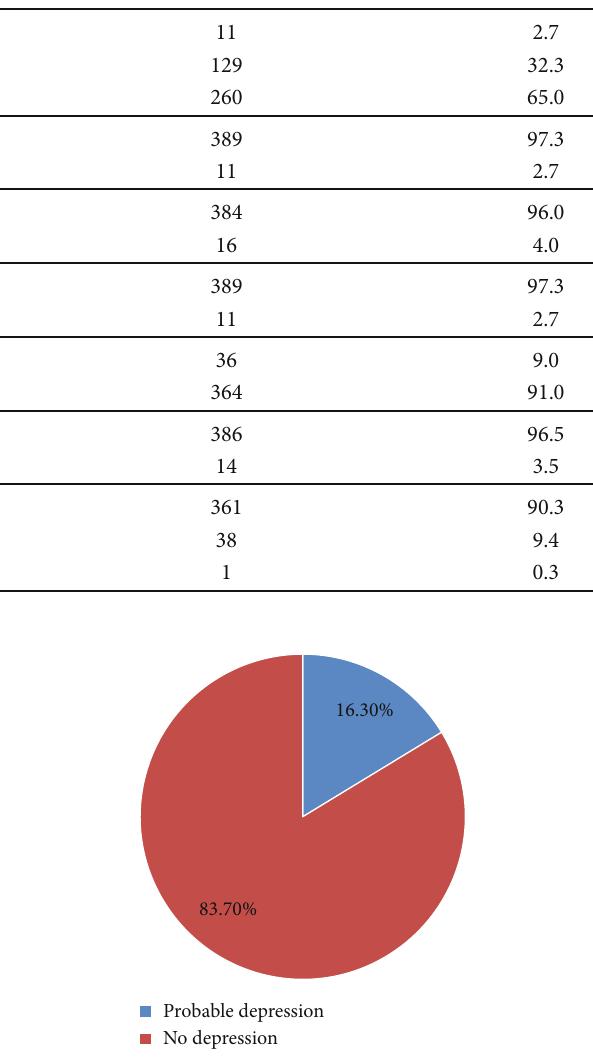
Figure 1: The magnitude of antenatal depression among pregnant women ( n = 400 ) attending antenatal care in Sodo town health facilities, Southern Ethiopia,